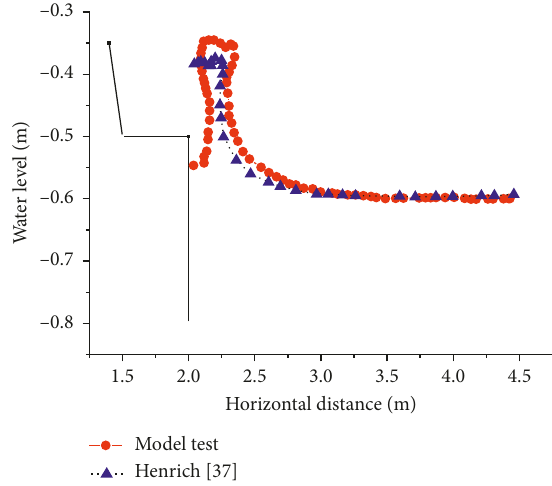
Figure 7: First landslide-generated wave height at different width- to-thickness